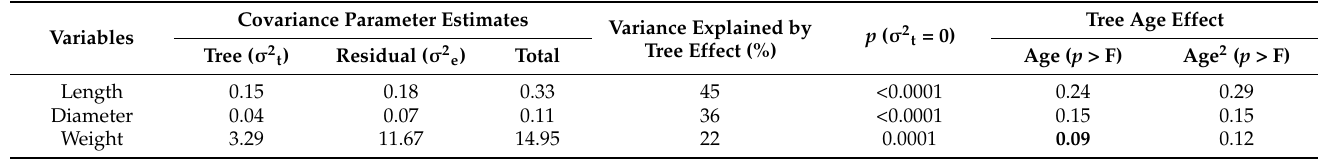
Table 3. Between-Tree Variability and Effect of Tree Age on Morphological Parameters of Seeds. When the effect of age is significant ( p < 0.1), the value is shown in bold.